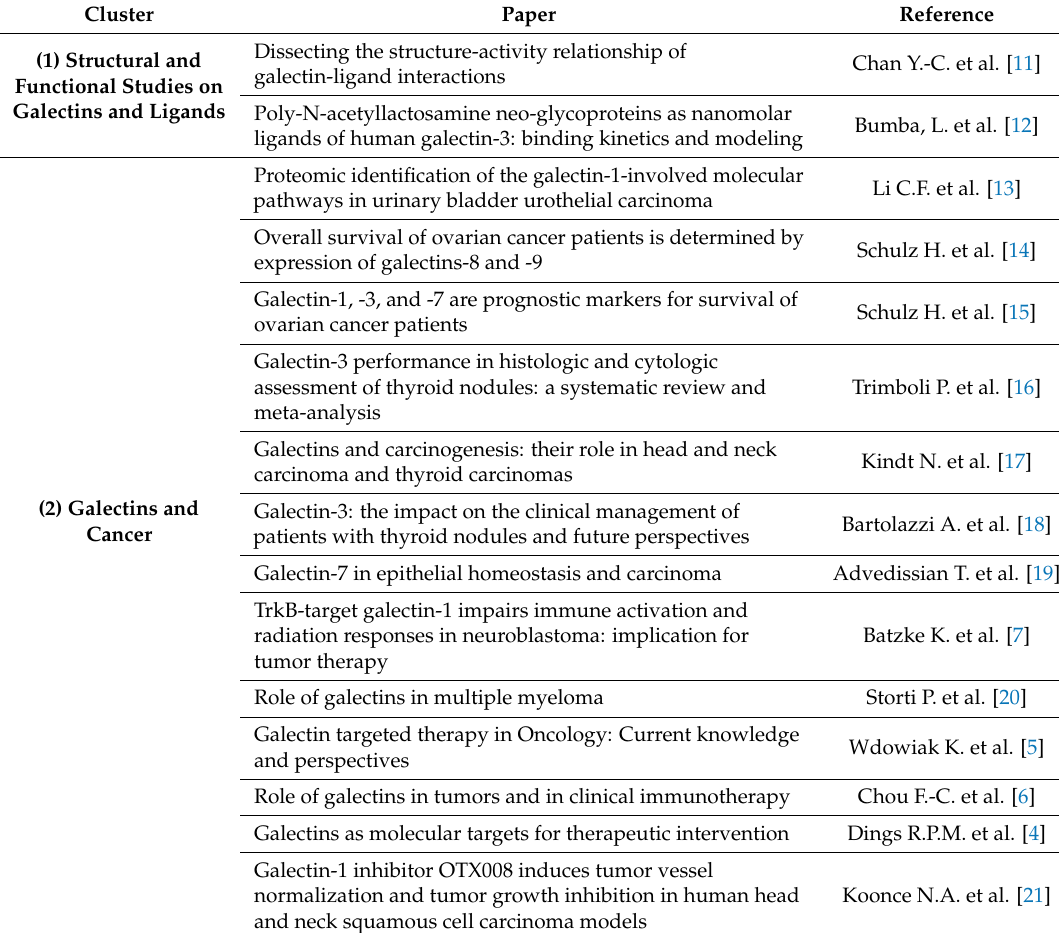
Table 1. Contributions to the special issue “Galectins in Cancer and Translational Medicine: From Bench to